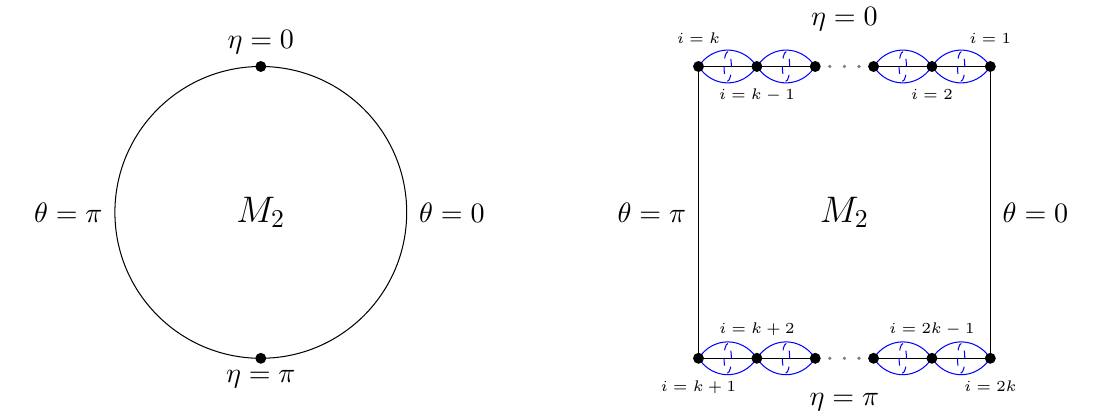
vanishes along the ψ